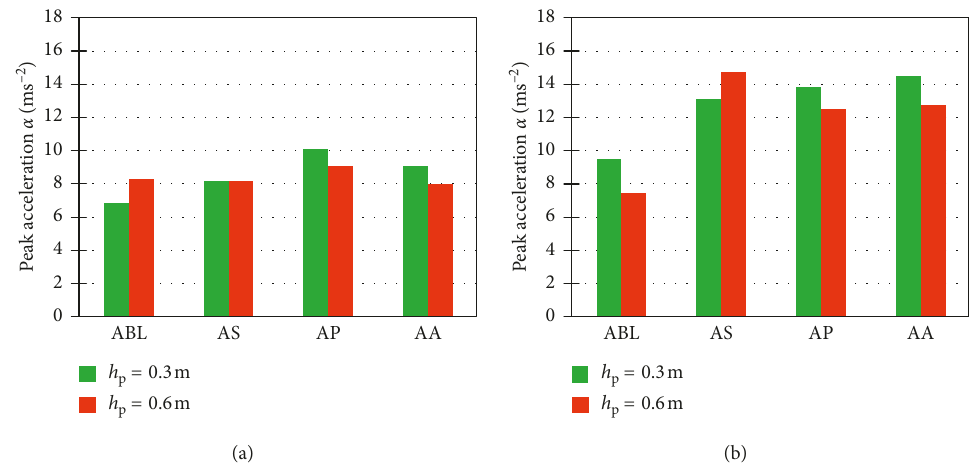
Figure 13: The effect of aseismic layer thicknesses on peak horizontal acceleration a . (a) PGA � 0.2g. (b) PGA �